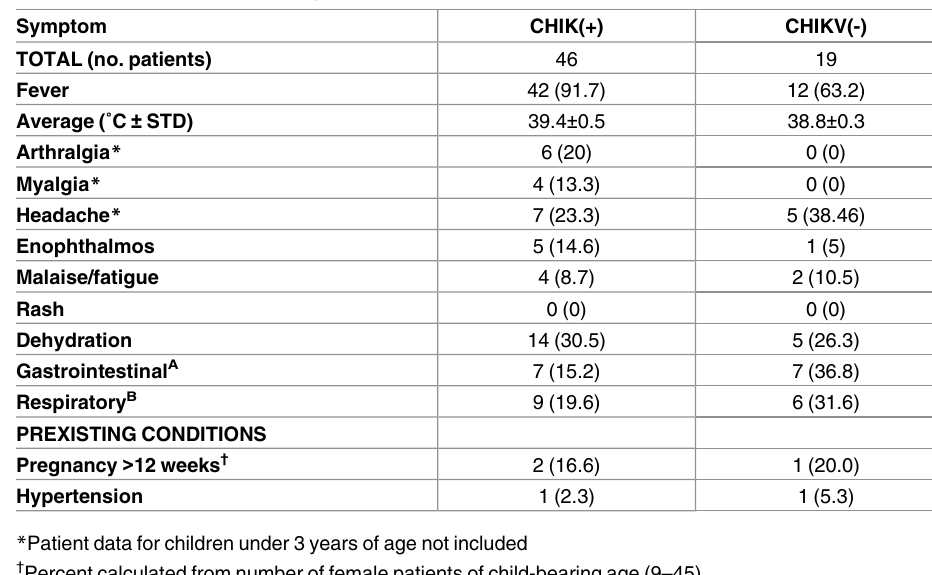
Table 3. Signs and symptoms recorded for CHIKF-positive (and CHIKF-negative) patients for whom complete blood counts were ordered between July 2014 and August 2014at Hospital Buen Samari- tano, La Romana, Dominican Republic.